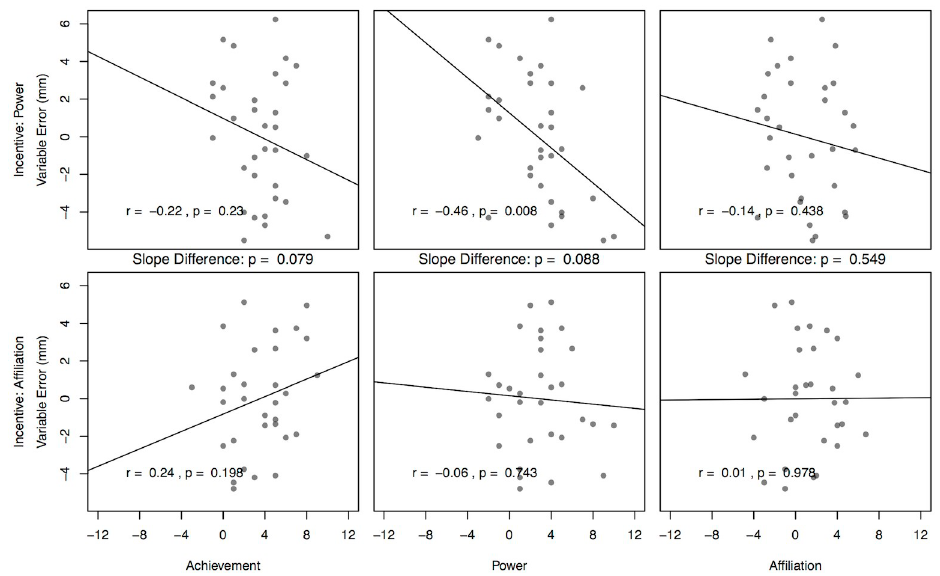
Fig 2. Motives and variable error by condition. Regressions of participants’ variable error (residualized for baseline performance) in the second block (lower = better) on each motive, separately for both experimental conditions (top vs. bottom row). All p-values are